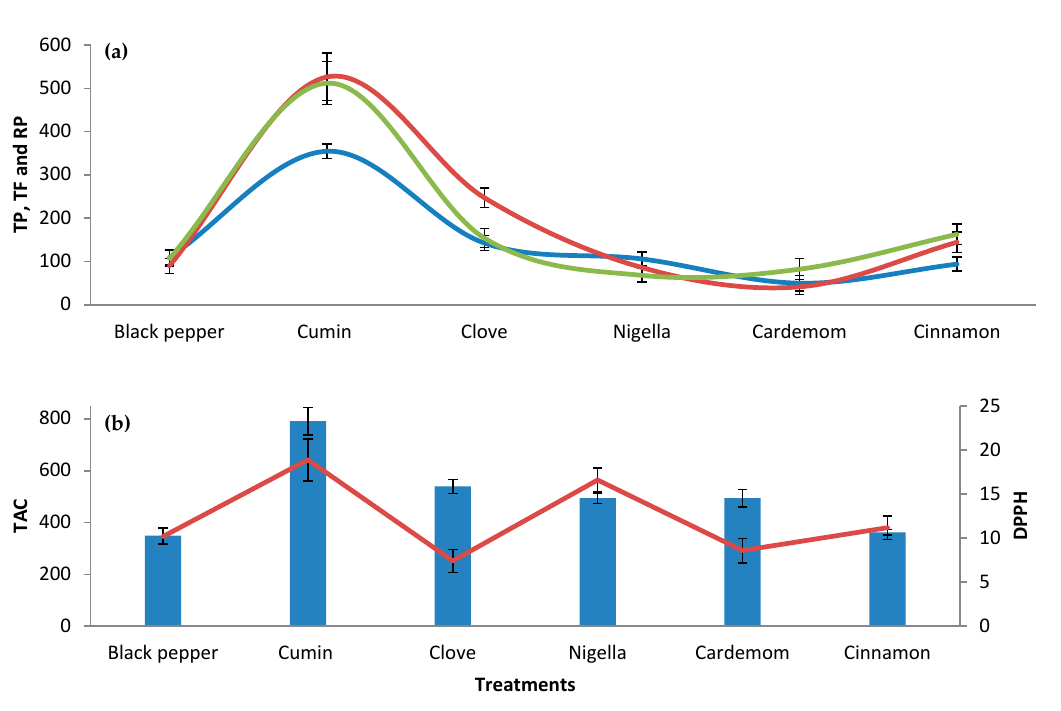
Figure 3. ( a ) Total phenolics (TP, means ± SD, mg GAE/100 g) (blue line), total flavonoids (TF, means ± SD, mg CE/100 g) (red line), reducing power (RP, means ± SD, mg TE/100 g) (green line), ( b ) total antioxidant activity (TAC, means ± SD) (blue bar, mg TE/100 g), and DPPH radical scavenging activity (means ± SD, red line, mM TE/g) of spices used for incorporation into paneer.